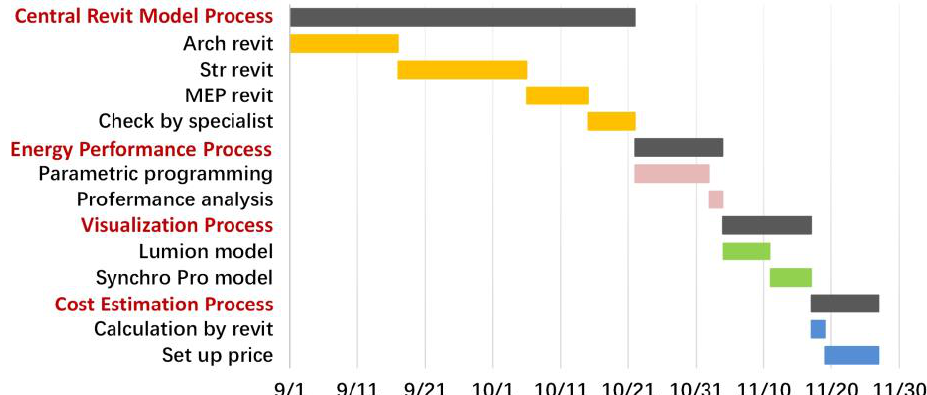
Figure 12. Period of BIM-assisted workflow simulation.